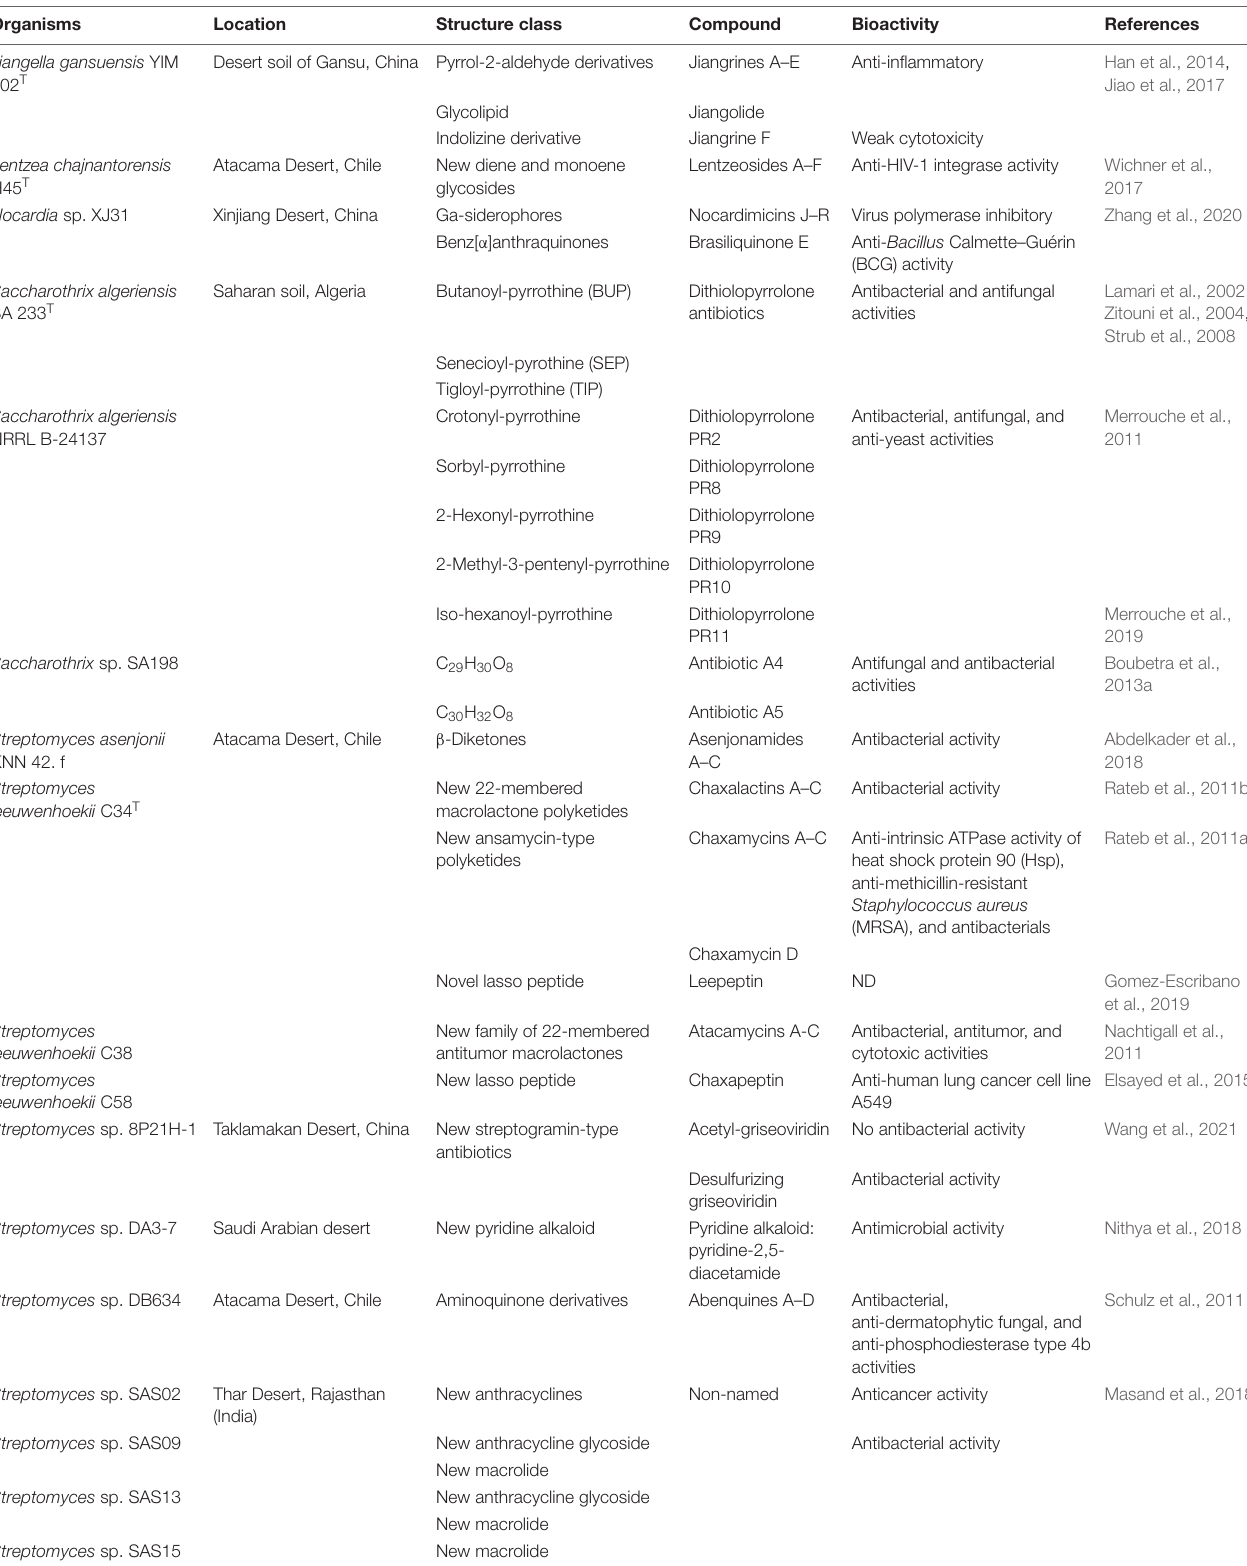
TABLE 3 | Novel natural products from desert actinobacteria between 2000 and